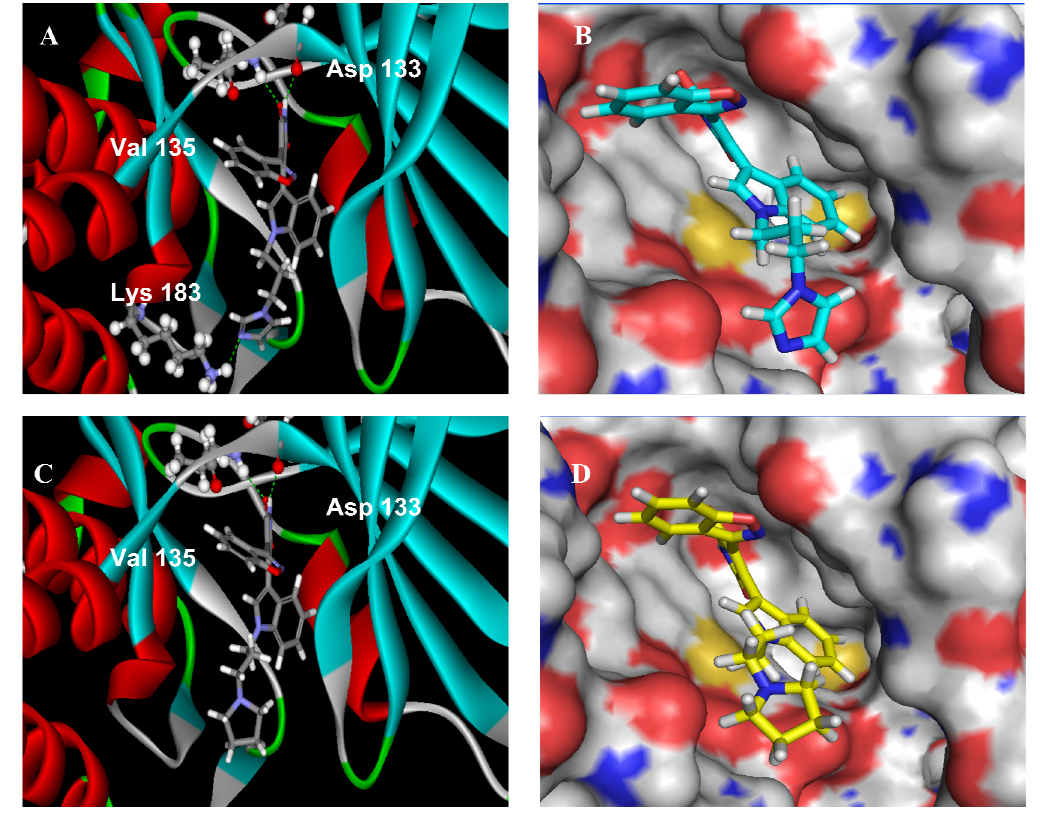
Figure 3. Docking of 7j to GSK-3 β crystal structure. ( A ) Ribbon show of compound 7j bound to GSK-3 β ; ( B ) Surface show of compound 7j dock into GSK-3 β . Main text paragraph; ( C ) Ribbon show of compound 7n bound to GSK-3 β ; ( D ) Surface show of compound 7n dock into GSK-3 β